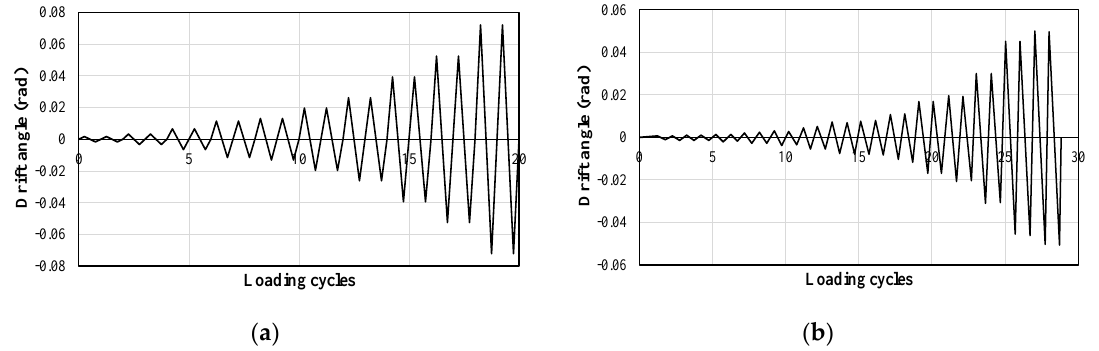
Figure 2. Reverse cyclic load used for ( a ) JBC1, JBC4 and JBC2 (adapted from [36, 37]) ( b ) J4 (adapted from [7]).